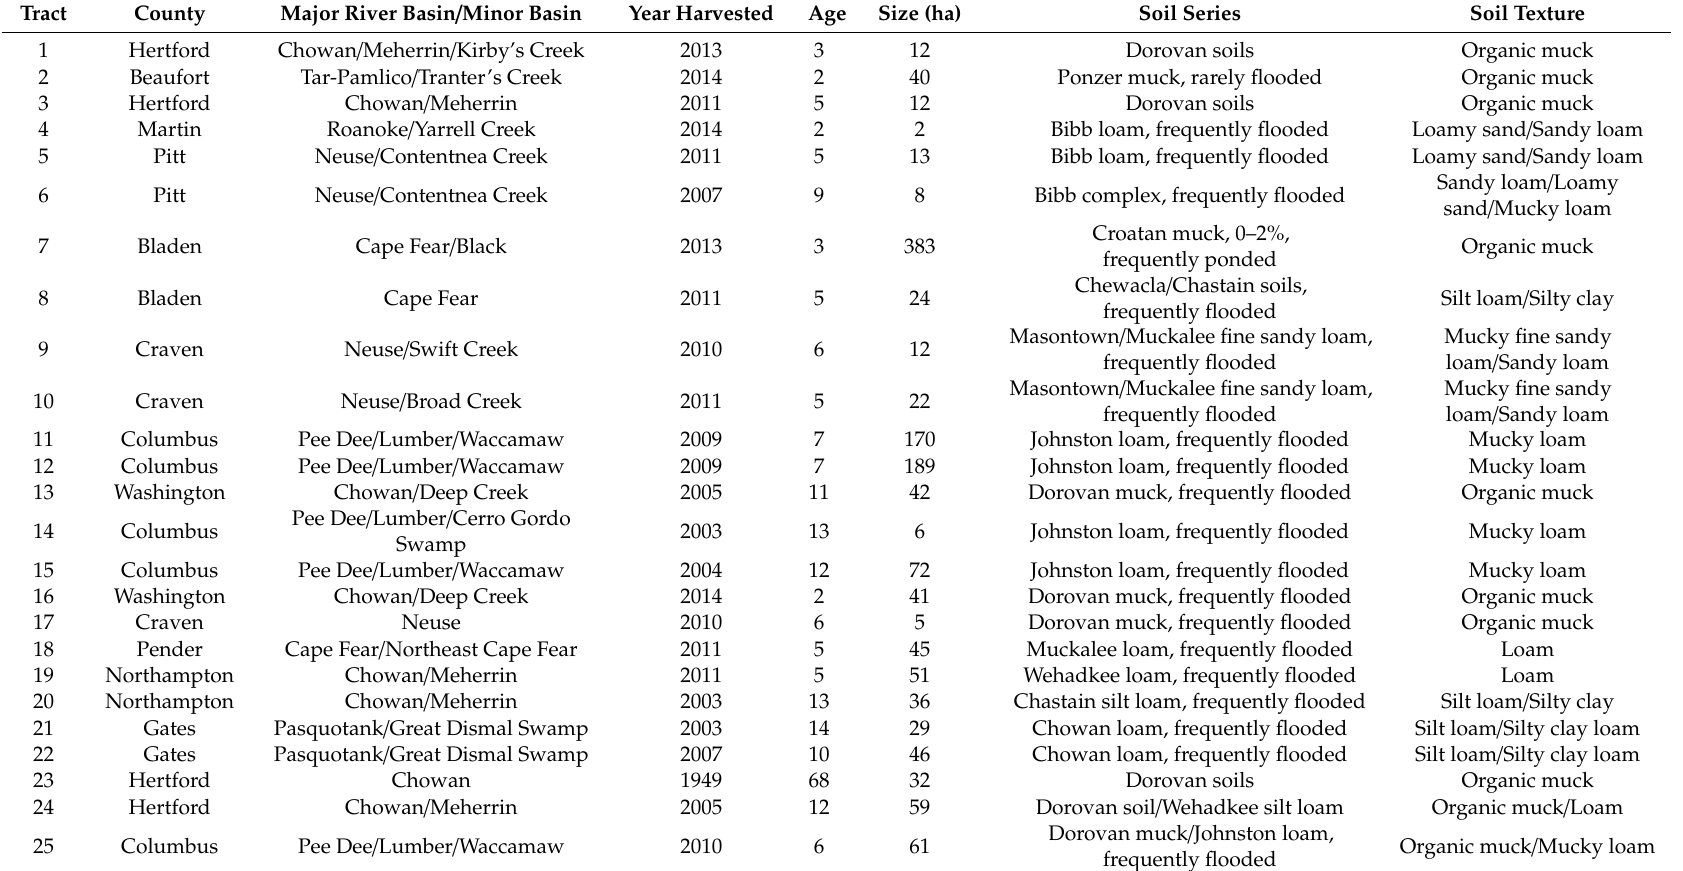
Table 1. Locations, year of timber harvest, stand age at the time of survey, and soil characteristics of each tract evaluated for